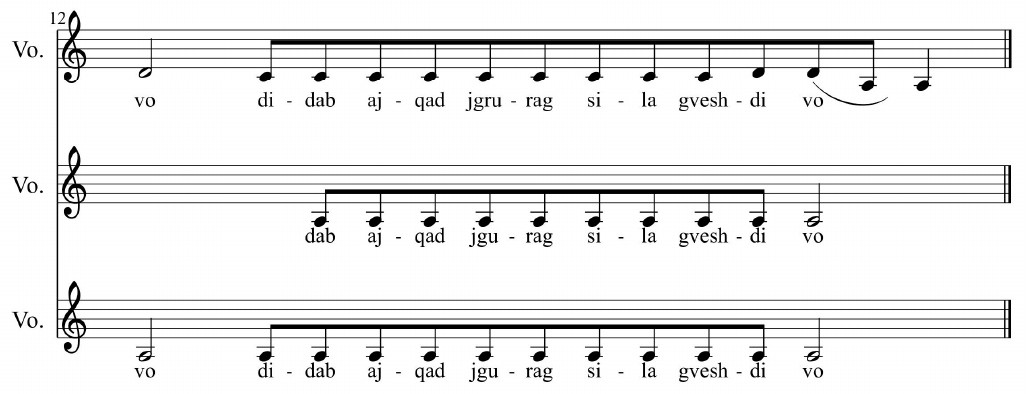
Figure 21. Jgragish; Svan hymn to St. George, Lakhushdi variant.